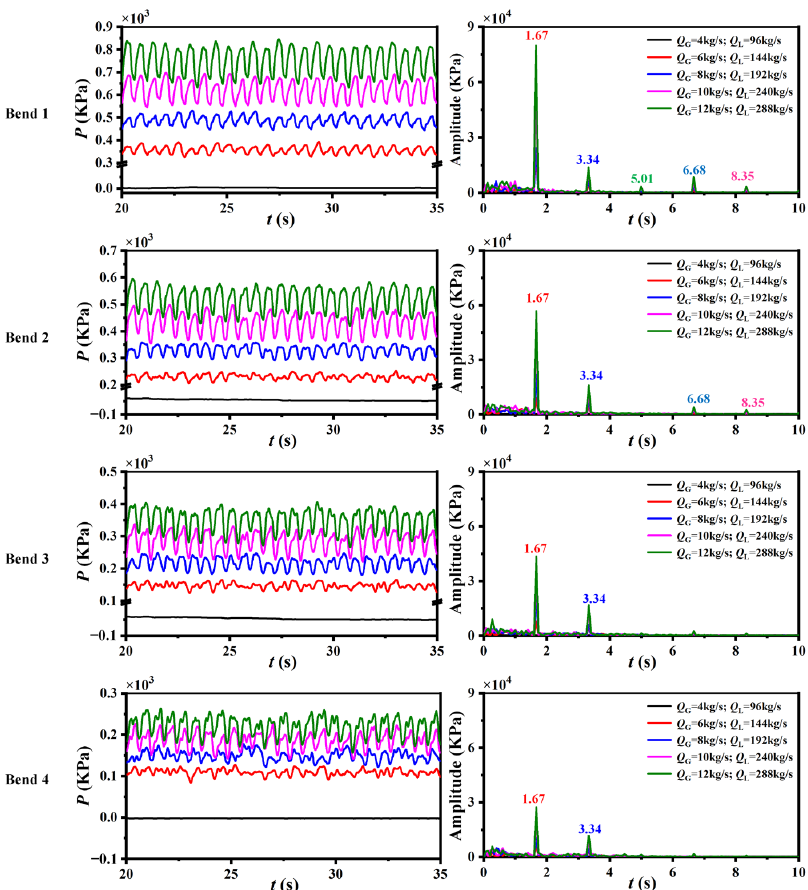
Figure 14. Time histories of the pressure acting on the four bends and associated frequency spectra at different inlet mass flow rates.